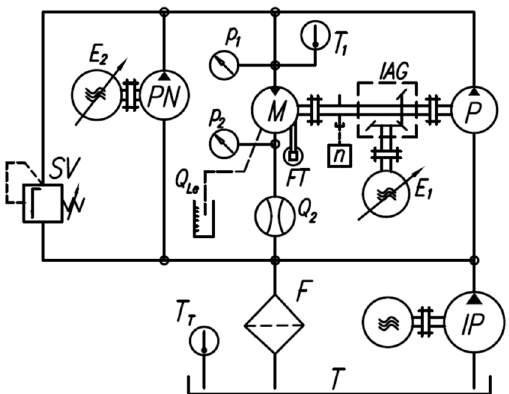
Figure 8. Diagram of the test stand measurement system [12,29]: P—pump, M—tested hydraulic motor , PN—pump for filling leaks in P and M, IP—impeller pump (pre-supply pomp), SV—safety valve, F—filter, T—reservoir, IAG—intersecting axis gear, E 1 and E 2 —electric motors with frequency converters, T 1 , T T —temperature sensors, Q 2 —flowmeter, Q Le —leakage measurement, FT—force transducer (torque measurement), n—inductive sensor (rotational speed measurement).